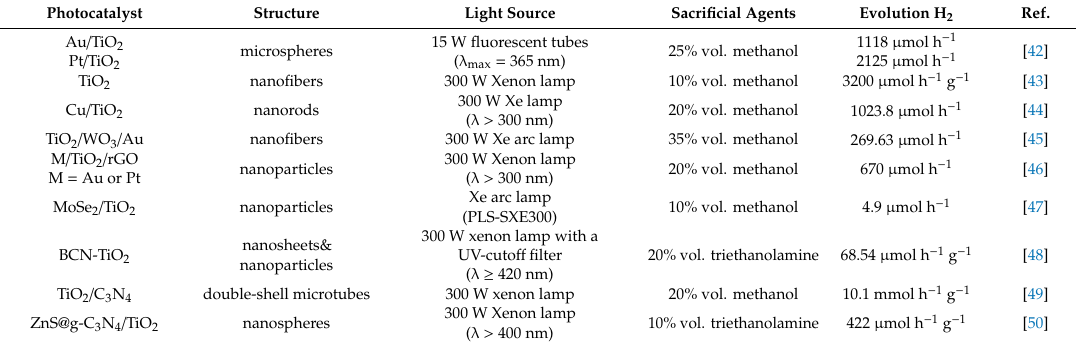
Table 1. TiO 2 -based photocatalysts with di ff erent structures utilized for hydrogen evolution under splitting water